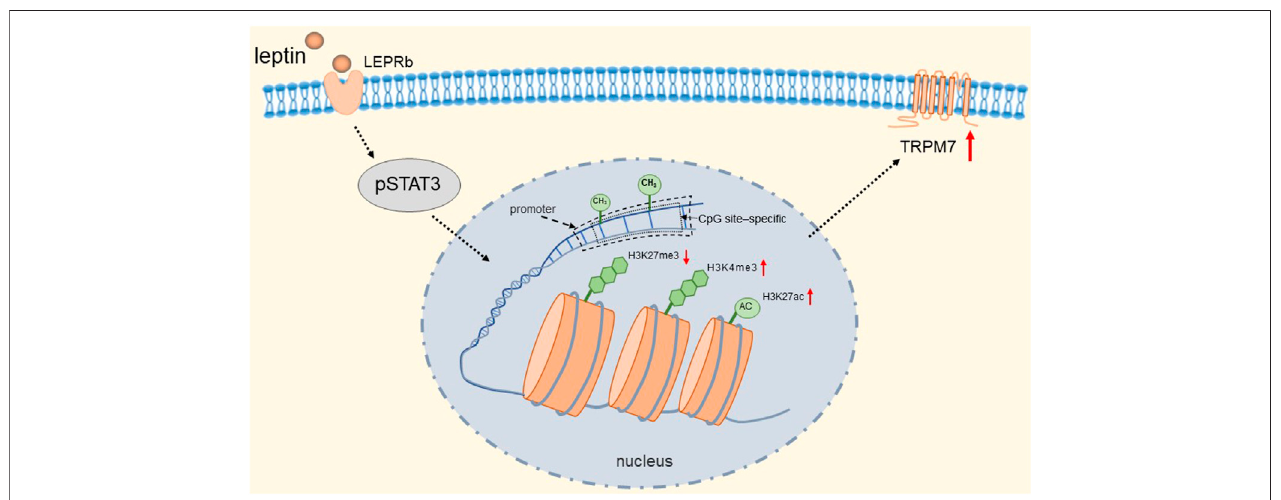
FIGURE 6 | Leptin induces epigenetic regulation of TRPM7. Activated pSTAT3 epigenetically regulates transcription of TRPM7 through DNA methylation and histone modi fi cations. Speci fi cally, it is manifested in a reduction in CpG site-speci fi c methylation and H3K27 trimethylation and an increase in H3K27 acetylation and H3K4 trimethylation at the TRPM7